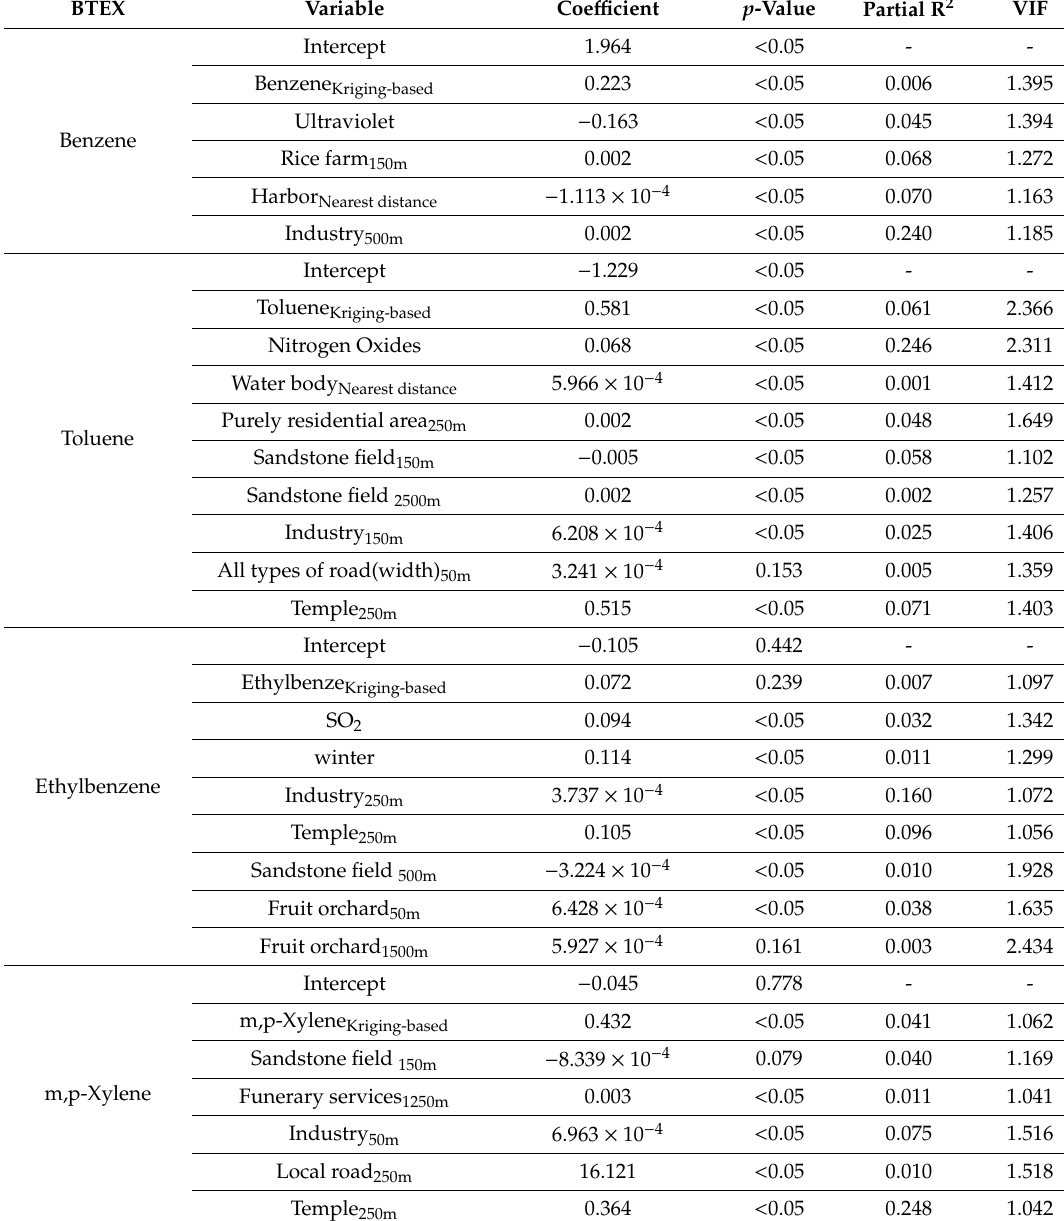
Table 1. Prediction variables for the Hybrid Kriging-LUR model. LUR—land-use regression; VIF—variance inflation